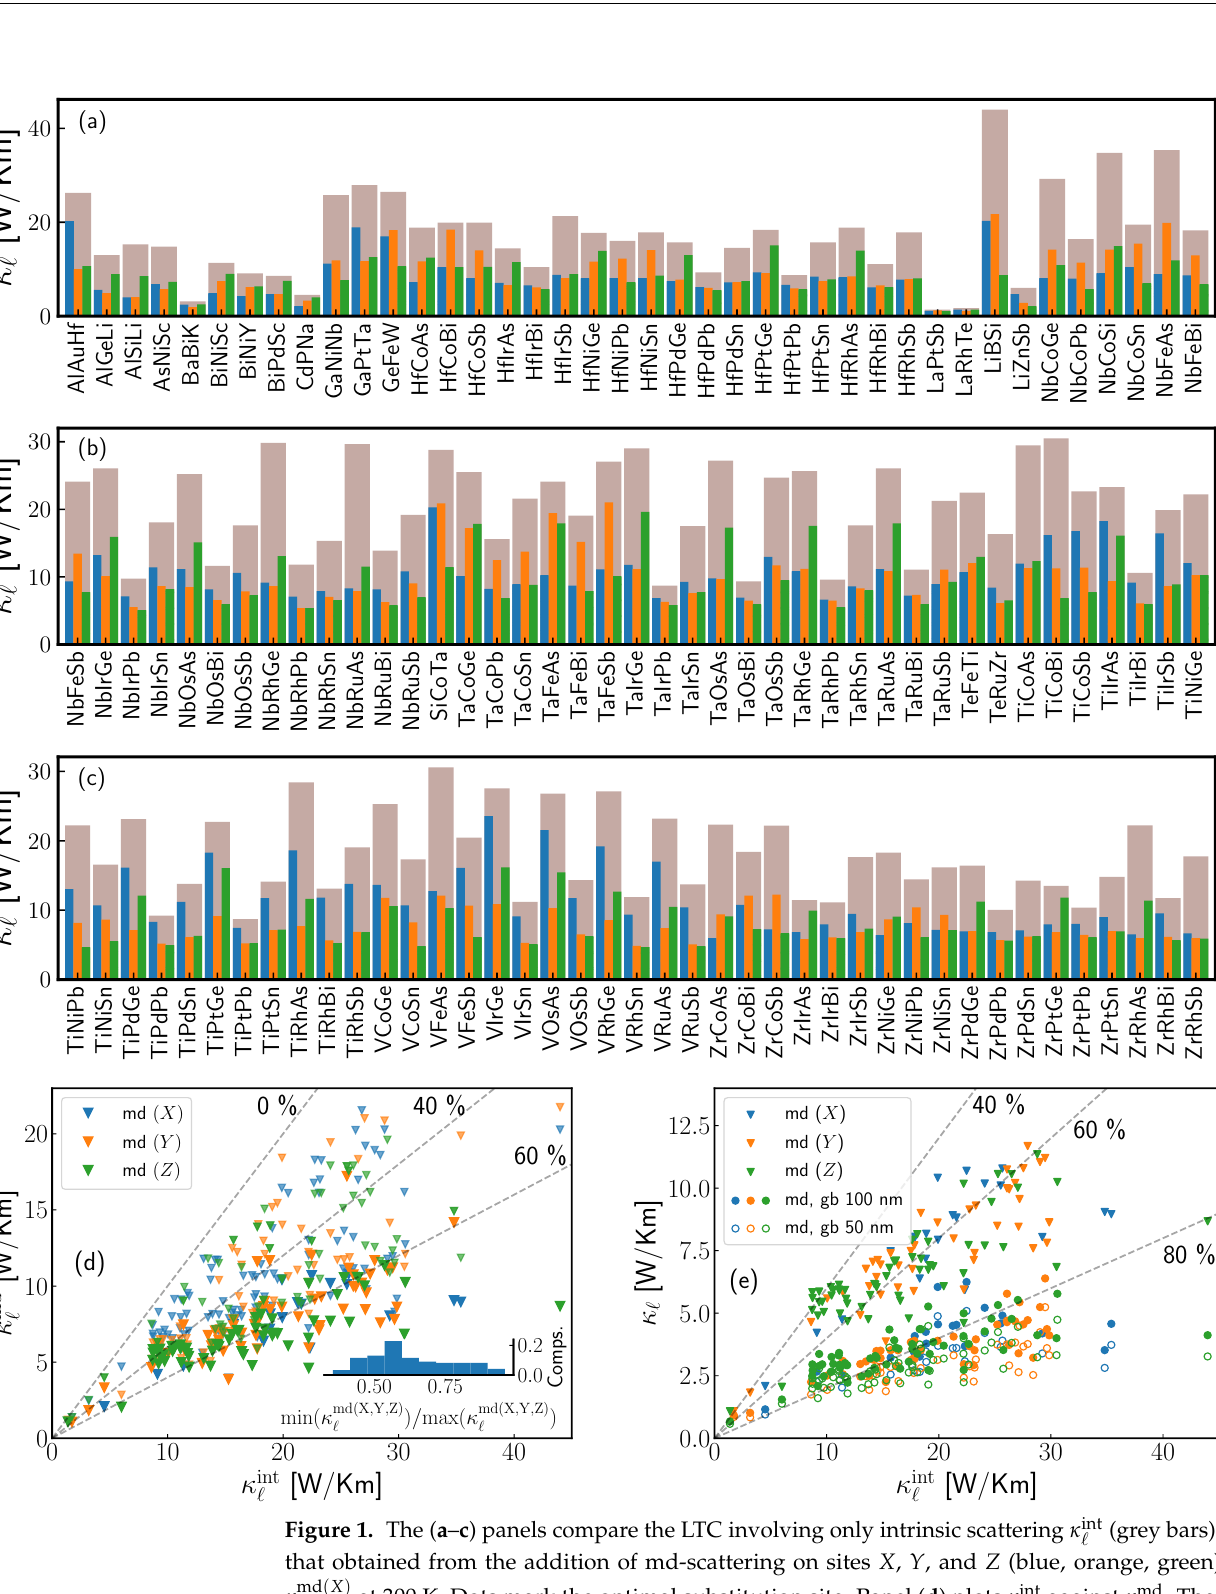
Figure 1. The ( a – c ) panels compare the LTC involving only intrinsic scattering κ int that obtained from the addition of md-scattering on sites X , Y , and Z (blue, orange, green), i.e., ( X ) κ md at 300 K. Dots mark the optimal substitution site. Panel ( d ) plots κ int (cid:96) against κ md (cid:96) . The blue, (cid:96) orange, and green triangles indicate substitution on the X -, Y -, and Z -sites, respectively, with the one most effectively reducing the LTC highlighted. The inset histogram shows the distribution of the most effective substitution divided by the least effective one, min ( κ md panel ( e ), only results for the most effective substitution site are shown; in addition filled (empty) discs indicate κ md,gb with gb size of 100 nm (50 (cid:96)